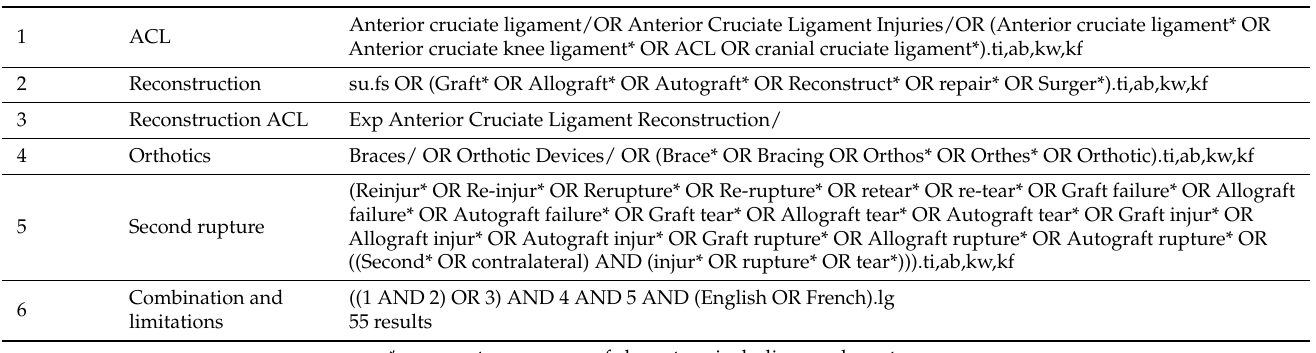
Table A2. Medline (Ovid) 9 June 2020.